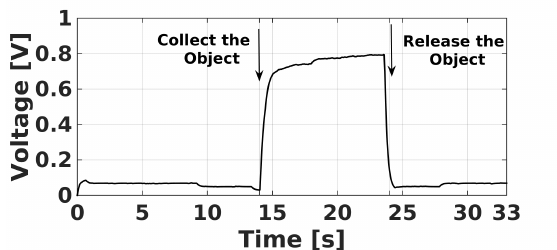
Figure 19. Voltage of the force sensor inside the